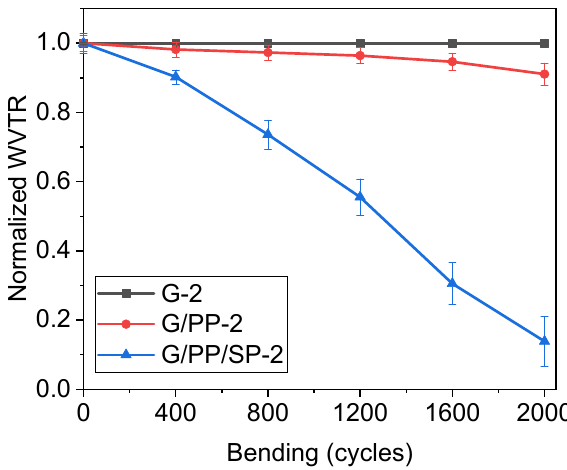
Figure 7. Normalized WVTR of edible films vs. the number of bending cycles with a bending radius of 6.35 cm. The black curve represents gelatin (G-2) film, the red curve represents G/PP-s film, and the blue curve represents G/PP/SP-2 films, and the thickness of each tested film is about 100 μ